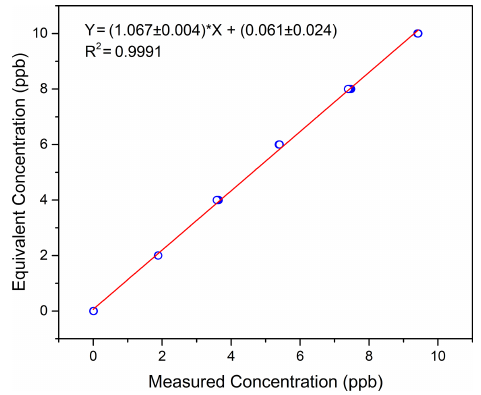
Figure 4. The linear fitting of calibration results for isoprene mea- surement.